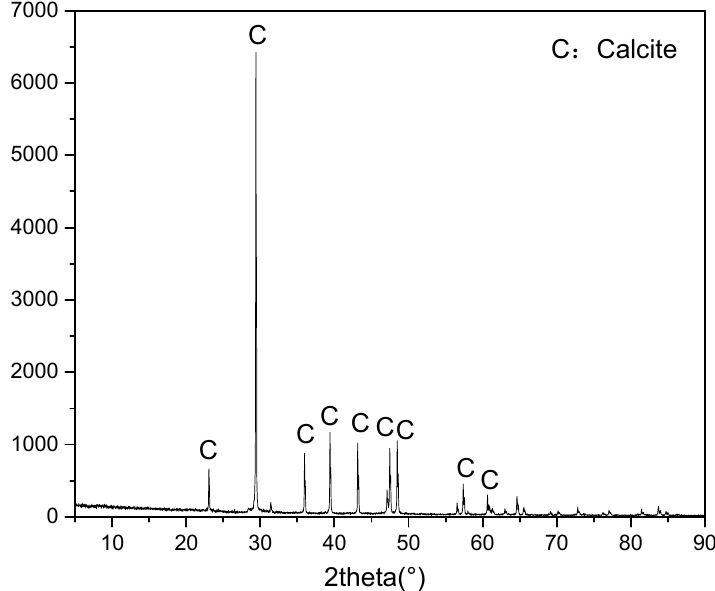
Figure 6. XRD pattern of bioprecipitations scraped from treated RFA.